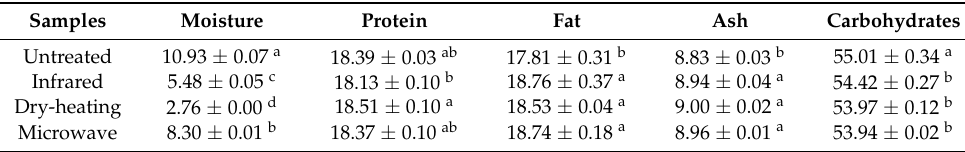
Table 1. Proximate composition (% db) of rice bran (RB) samples before and after heat treatments.